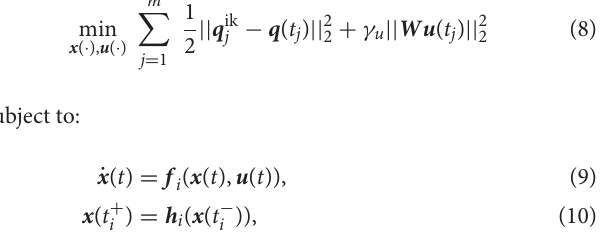
For non-redundant constraints g ( q ) the contact Jacobian G ( q ) has full rank and (3) can be uniquely